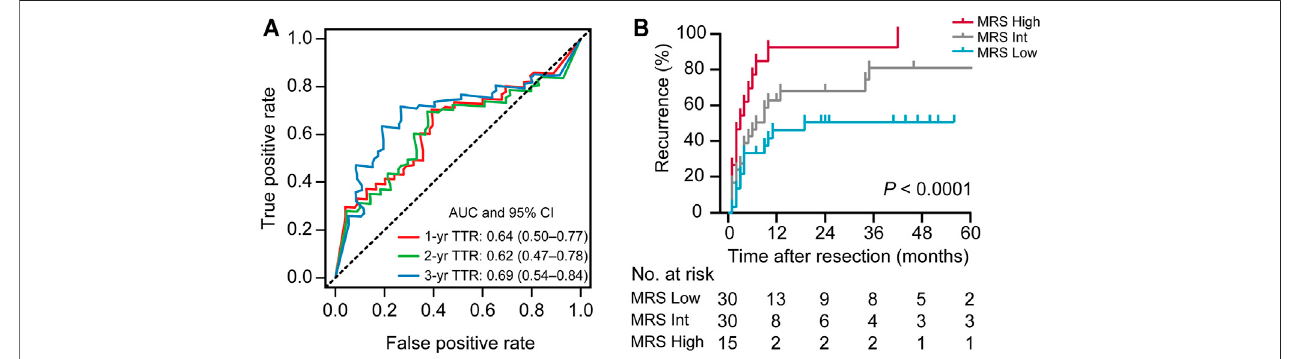
FIGURE 2 | The prognostic performance of the MRS in iCCA. (A) Receiver operating characteristic (ROC) curve analysis showed the discriminatory ability of MRS (as a continuous score) for predicting 1, 2, and 3 years recurrence of iCCA after resection. (B) Kaplan-Meier survival analysis of time to recurrence (TTR) of patients in iCCAaccordingtotheMRS(asacategoricalvariable).CutoffsweredeterminedusingtheX-tileprogramasdescribedin SupplementaryFigureS1 ,dividingthecohort intothreesubgroups(MRS Low ,0 – 35.7;MRS Int ,35.7 – 97.0;MRS High ,97.0 – 100; SupplementaryFigureS1 ).Theareaundercurve(AUC)wasshownasthemean and